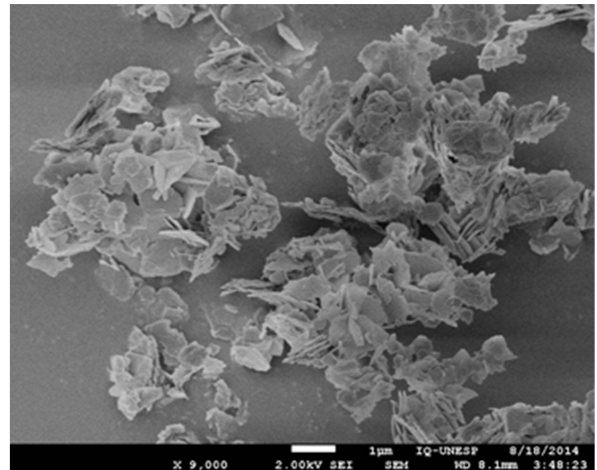
Figure 6. SEM image of a ZnAl-Cl-LDH. Source: Tronto (non-published data).